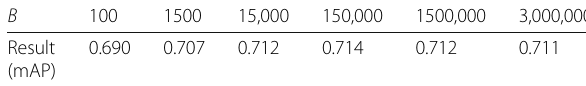
Table 1 The influence of B on retrieval